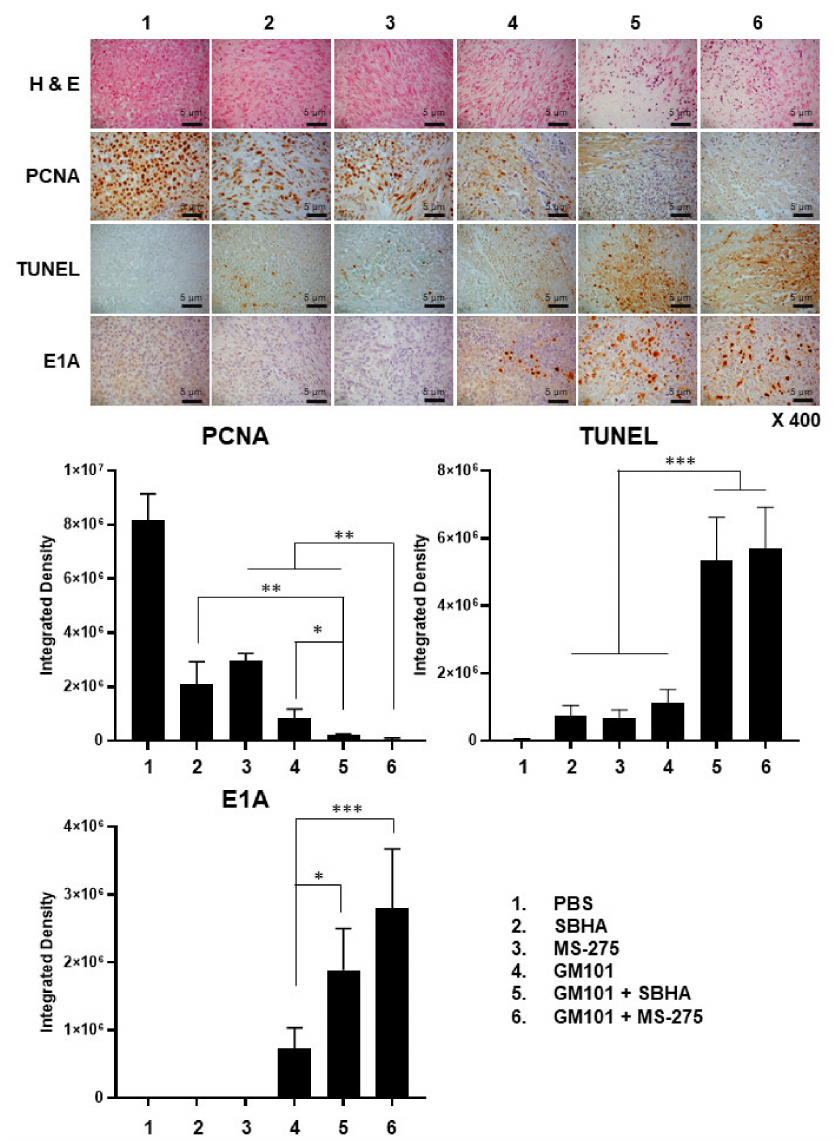
Figure 6. Histological and immunohistochemical analysis of tumor tissues. U343 xenograft tumors were established in nude mice through subcutaneous injection to the abdominal skin. Once the aver- age tumor volume reached 100 mm 3 , tumor-bearing mice were treated with PBS, SBHA (200 mg/kg), MS-275 (20 mg/kg), GM101 (5 × 10 9 VP), GM101+SBHA, or GM101+MS-275. Tumor tissues were harvested for histological and immunohistochemical analysis on the 9 th day after initial treatment. Tumor sections were stained with hematoxylin and eosin (H & E), proliferating cell nuclear antigen (PCNA)-specific antibodies, terminal deoxynucleotidyl transferase dUTP nick end labeling (TUNEL), or Ad E1A-specific antibodies. Representative images are shown. Original magnification: × 400. The scale bar represents 5 µ m. Immunohistochemical staining results were semi-quantitatively analyzed using ImageJ analysis software. Data are presented as the mean integrated optical density ± SD ( n = 3 mice per group; optical density was analyzed from five random fields). * P < 0.05, ** P < 0.01, *** P <